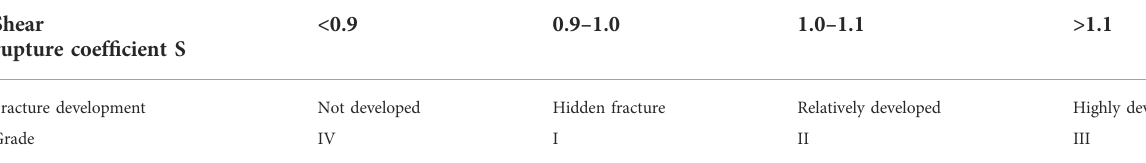
TABLE 4 Evaluation results of structural fracture development areas in shale reservoirs in Lintanchang Area.